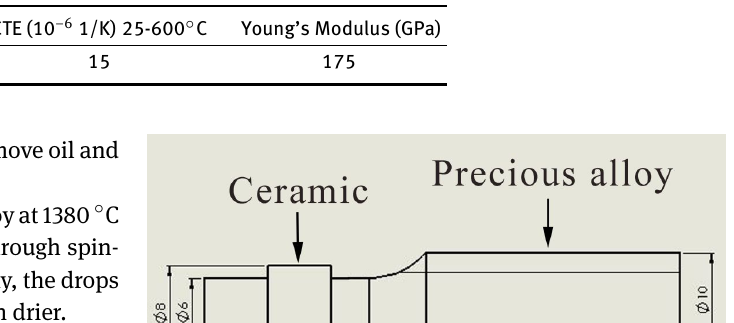
Table 2: Relevant material properties 31